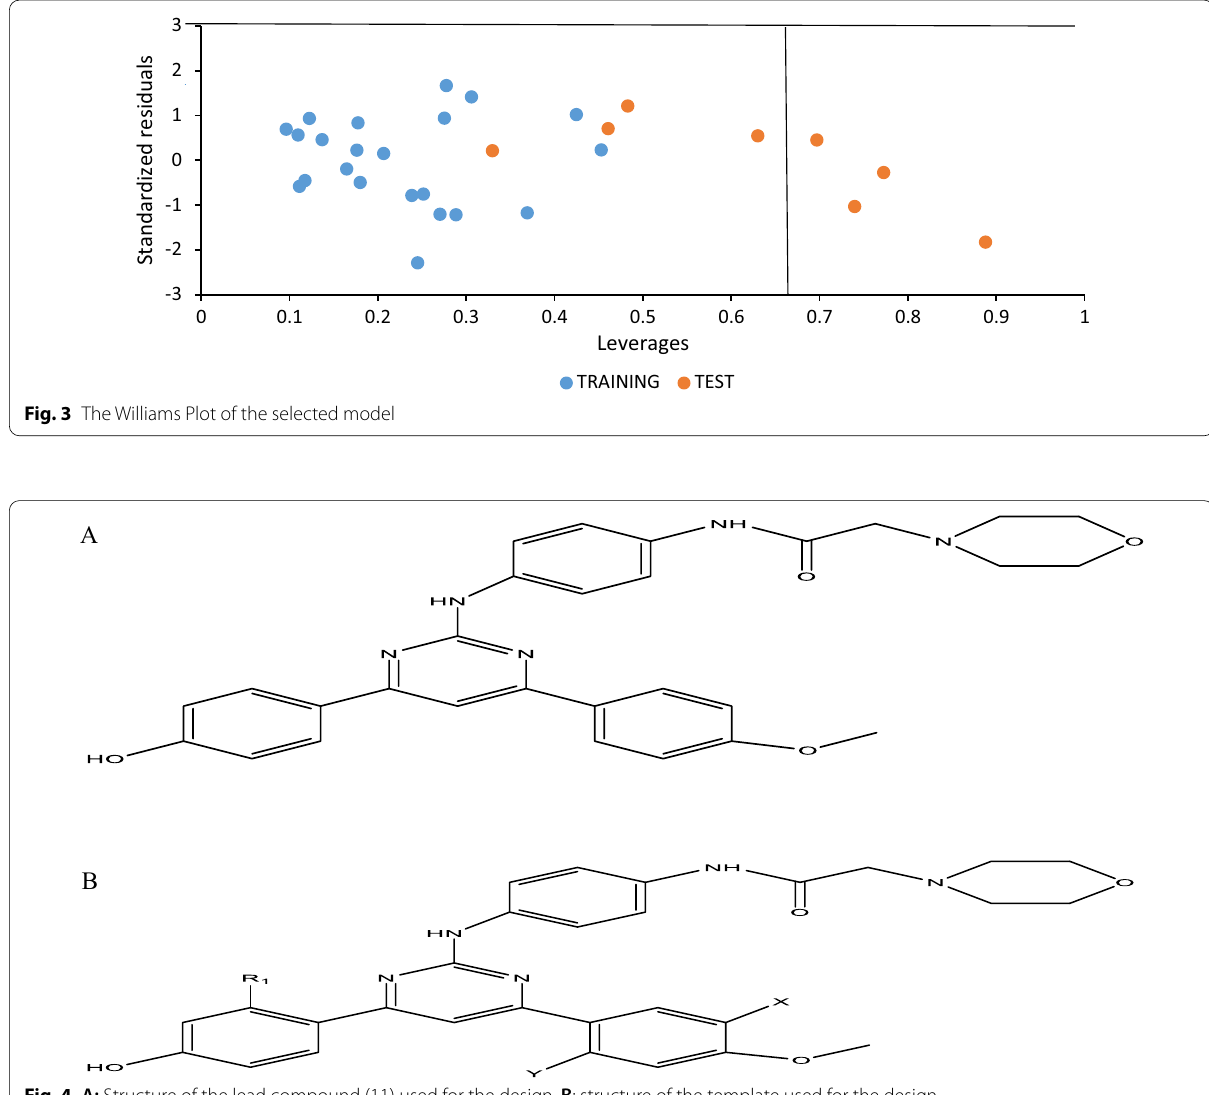
Fig. 4 A: Structure of the lead compound (11) used for the design. B : structure of the template used for the